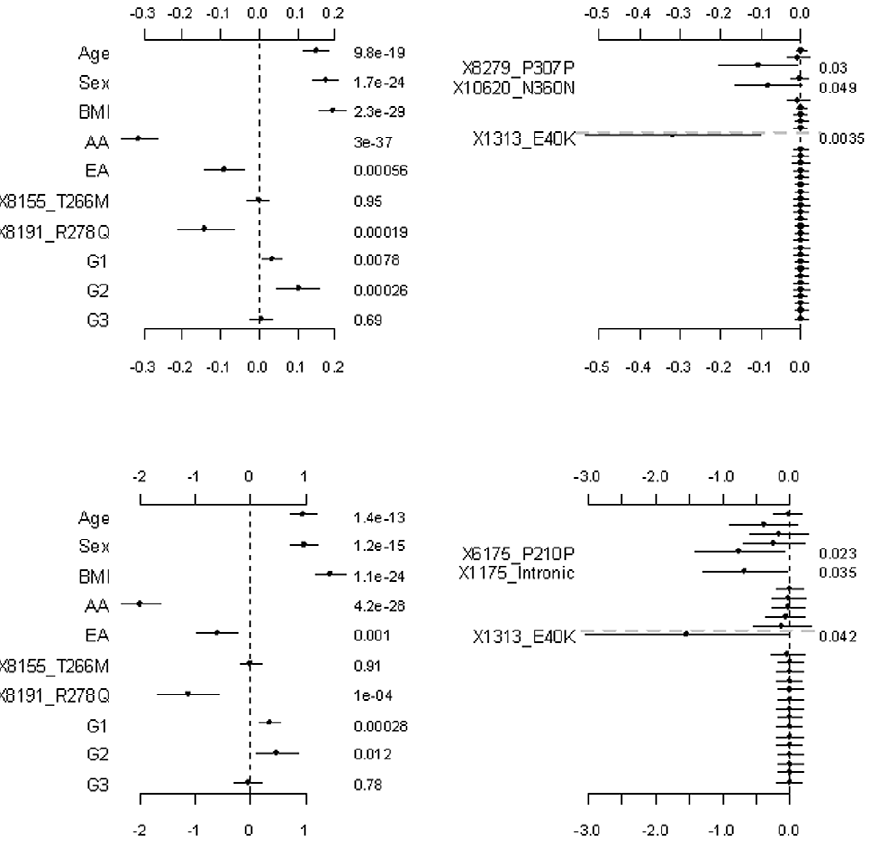
Figure 3. Analyses of the proposed hierarchical GLMs with prior means m j being the functional probabilities for the rare non- synonymous variants. The top and bottom panels are for the continuous and binary traits, respectively. The left panel is for the covariates, the two common non-synonymous variants and the three group effects (G1: common synonymous; G2: rare non-synonymous; G3: rare synonymous). The right panel is for the adjusted main effects (the gray dotted line shows the two groups G1 and G2). The points, short lines and numbers at the right side represent estimates of effects, 6 2 standard errors, and p -values, respectively. Only adjusted main effects with p -value , 0.1 are labeled.